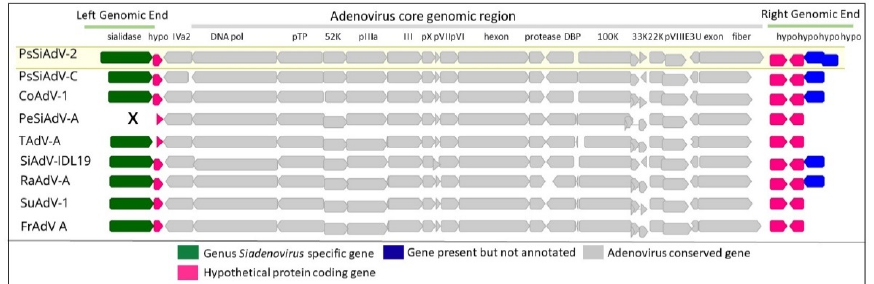
Figure 4. Schematic representation of siadenovirus genome comparison. Complete siadenovirus genomes were extracted from the following: NCBI ( Psittacine siadenovirus F (PsSiAdV-F), GenBank Ac no. MW365934; Psittacine siadenovirus C (PsSiAdV-C), GenBank Ac no. MN687905; Corella adenovirus A (CoAdV-A), GenBank Ac no. MK227353; Penguin siadenovirus A (PeSiAdV-A), GenBank Ac no. KP144329; Turkey adenovirus A (TAdV-A), GenBank Ac no. AC_000016; Siadenovirus—strain IDL 19 (SiAdV-IDL 19), GenBank Ac no. MK695679; Raptor adenovirus A (RaAdV-A), GenBank Ac no. EU715130; Skua adenovirus B (SuAdV-B), GenBank Ac no. HM585353 and Frog siadenovirus A (FrAdV- A), GenBank Ac no. NC_002501); they were aligned with MAFTT (version 7.388) [21] in Geneious Prime ® (version 2022.1.1, Biomatters, New Zealand). Adenovirus conserved genes,